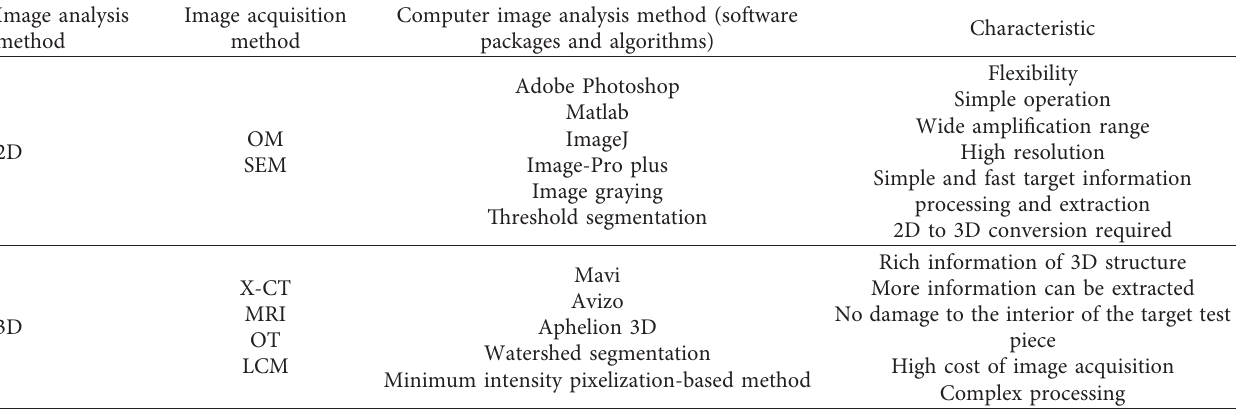
Table 1: Comparison of 2D and 3D image analysis